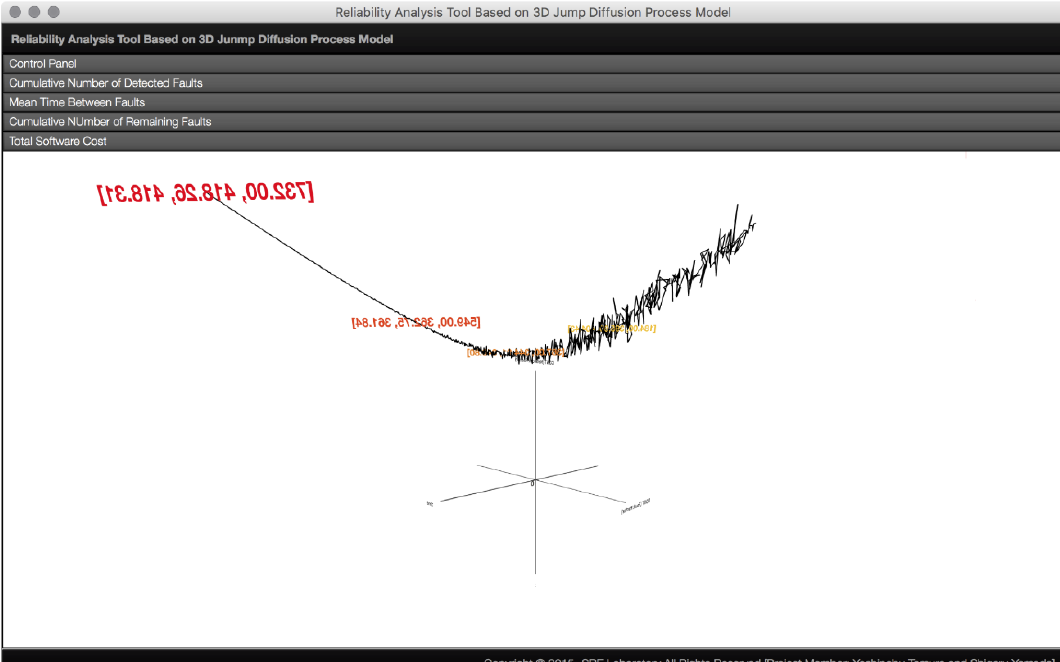
Fig. 4. The sample path of the estimated number of remaining faults